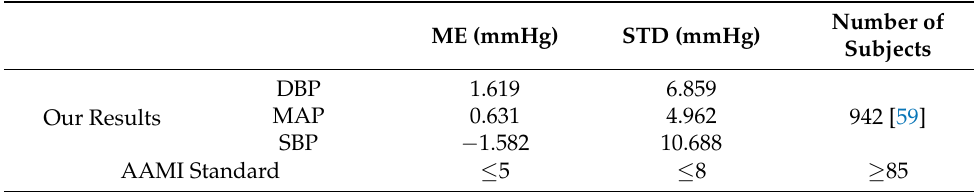
Table 3. Evaluation of AAMI Standard. Here, we present the criterion used in grading the rank of predictions using the AAMI Standard. We also demonstrate how our results compare with the AAMI Standard.